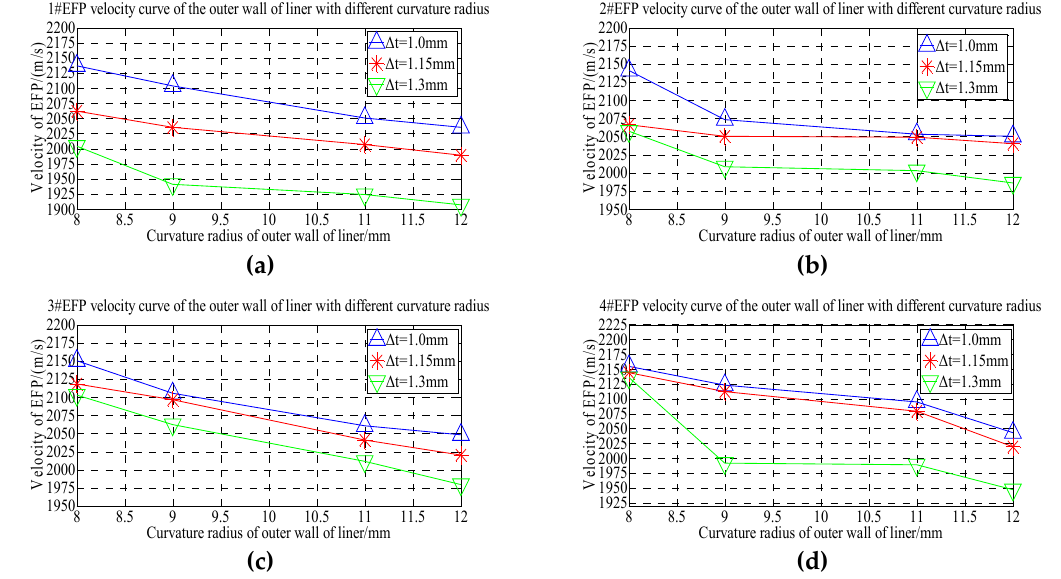
Figure 15. 1#EFP-4#EFP velocity curve of the center of the liner with di ff erent thickness: ( a ) 1#EFP velocity curve; ( b ) 2#EFP velocity curve; ( c ) 3#EFP velocity curve;( d ) 4#EFP velocity